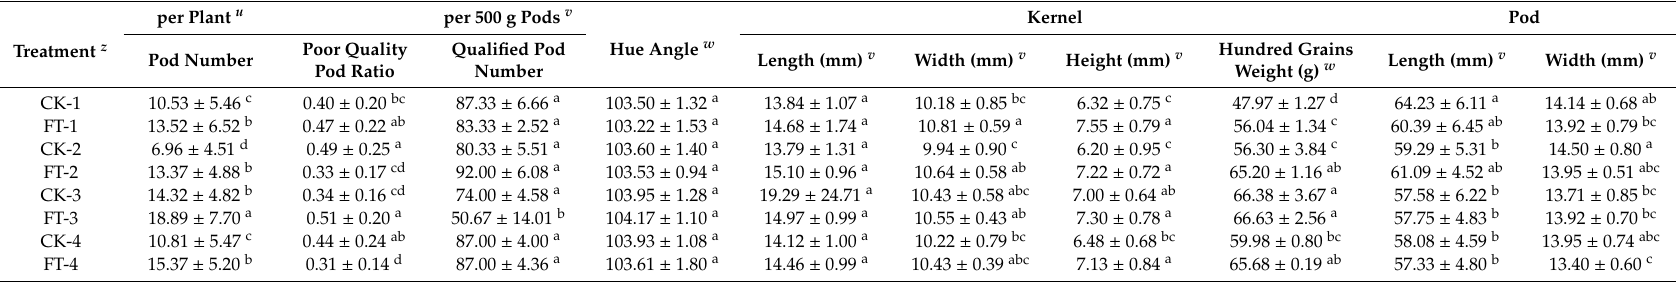
Table 3. Pod number and quality per plant, qualified pod number per 500 g pods, hue angle, and kernels and pods size of flooding treated vegetable soybeans ‘Kaohsiung